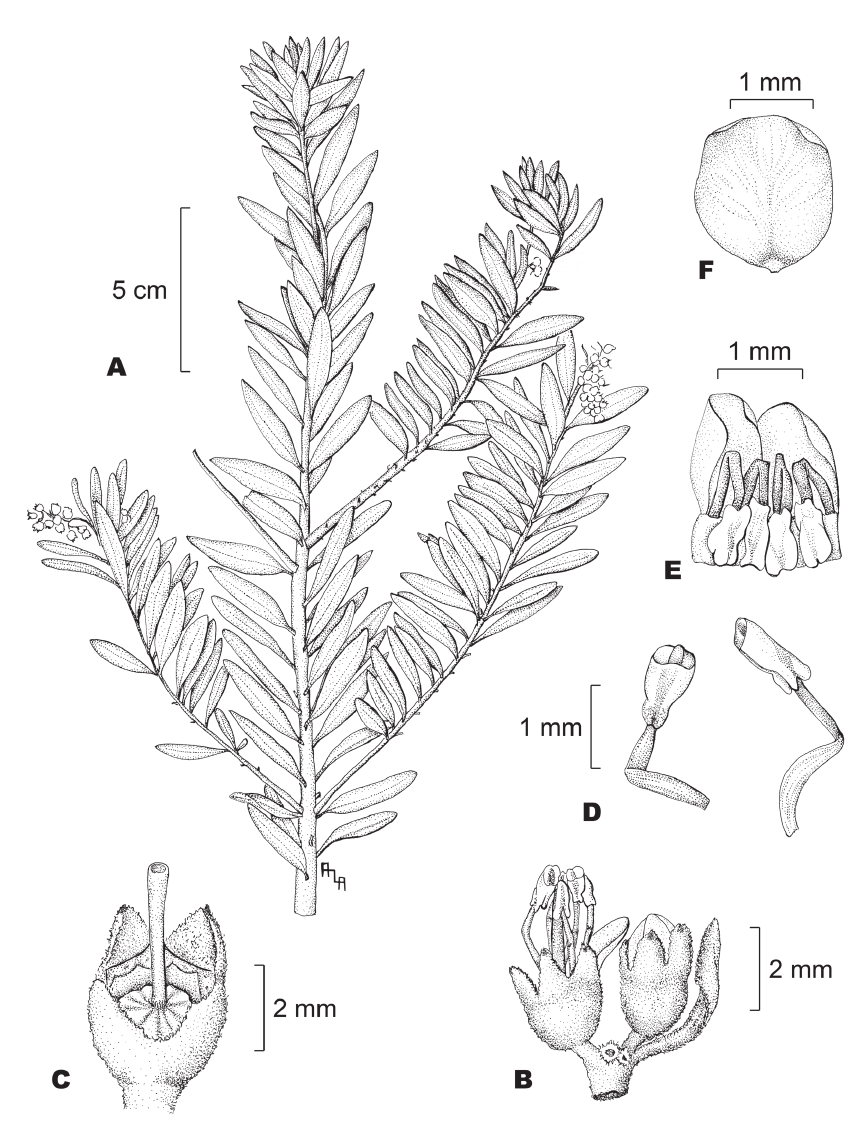
Figure 1. Miconia machinazana C. Ulloa & D.A. Neill, A fertile branch B partial inflorescence and flower bract C young fruit crowned by calyx lobes and style D stamens, ventral (left) and lateral views E young stamens folded inside a partial flower bud F petal, ventral view. Line drawing by A.L.Arbeláez; voucher Neill & Kajekai